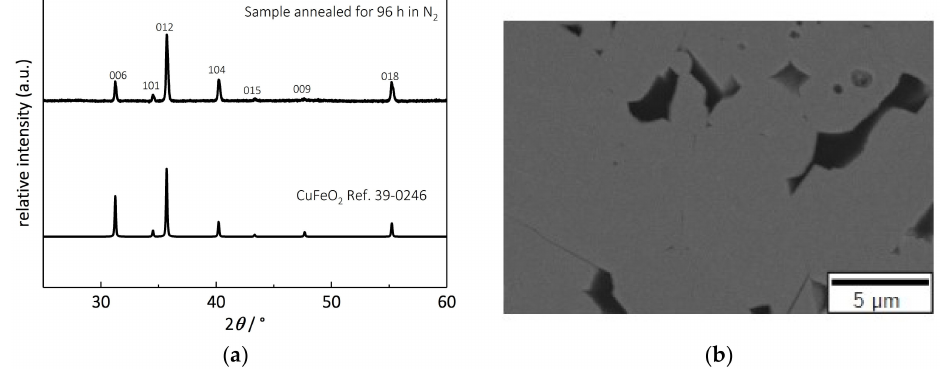
Figure 6. Delafossite annealed for 96 h at 900 ◦ C in nitrogen. ( a ) Diffraction and reference patterns of CuFeO 2 for comparison; ( b ) scanning microscope image (BSE detector) of the annealed sample showing no secondary phases. The dark areas are voids resulting from sample